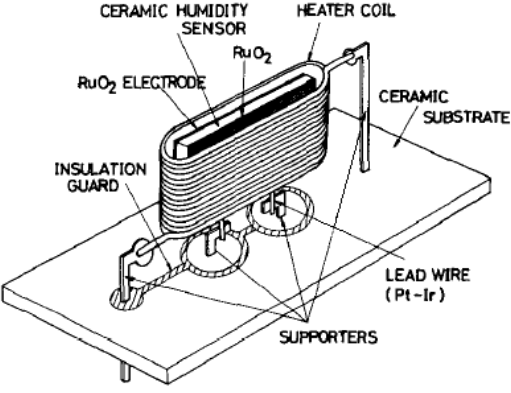
O -TiO ceramic humidity sensor 2 4 2